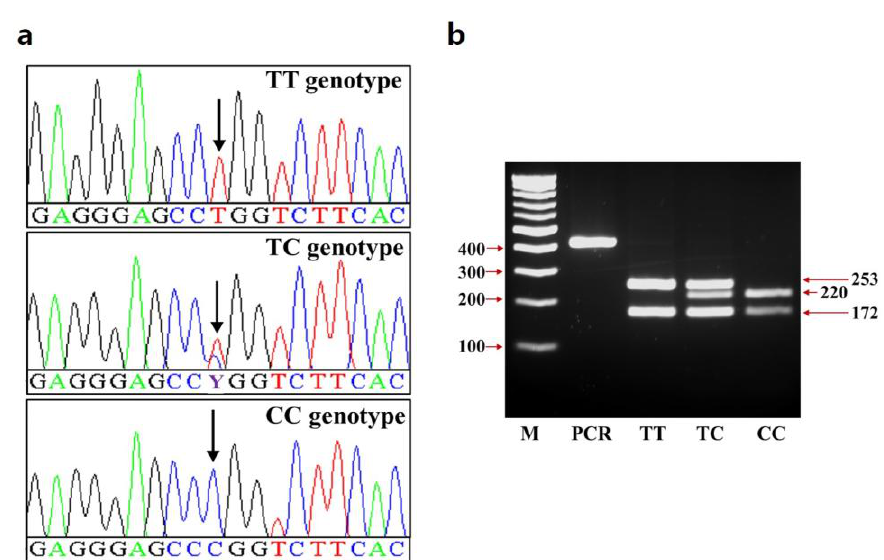
Figure 1. Genotypes of the c.*2041T>C SNP in the 3′ UTR of the SCD gene. (a) Sequence chromatograms showing c.*2041T>C SNP. (b) The electrophoresis image of PCR-RFLP for c.*2041T>C SNP. Digestion of PCR products (425 bp) by Msp I, show genotypes TT, TC, and CC. The arrowheads show and the size of DNA ladder and fragments. SNP, single nucleotide polymorphism; UTR, untranslated region; SCD , stearoyl-CoA desaturase; PCR-RFLP, polymerase chain reaction-restriction fragment length